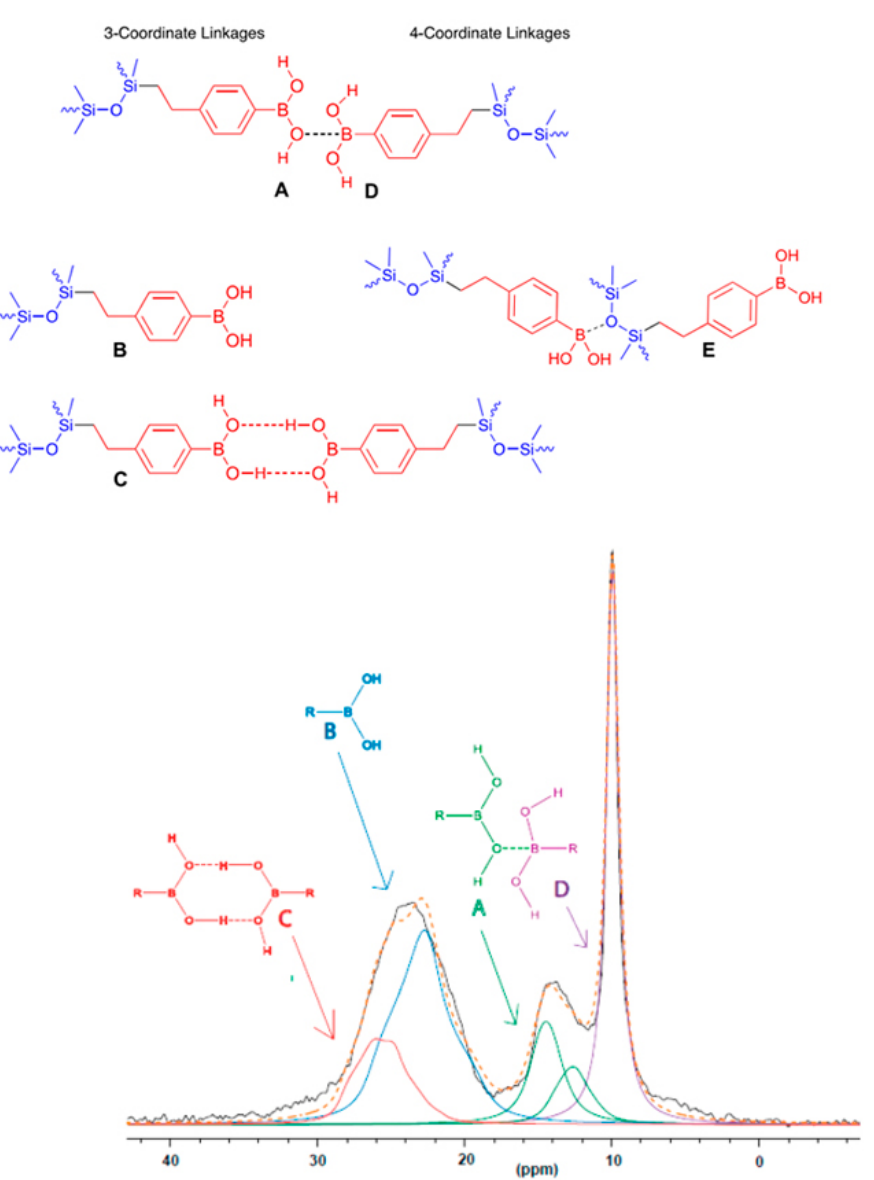
Figure 6. Types of noncovalent interactions between phenylborate moieties in organic PBSs and the type of MQMAS NMR spectrum that confirms their presence. Dative bonding between boronic acids (A), free boronic acid (B), and hydrogen-bonded boronic acids (C). Four-coordinate: dative bonding between a boronic acids (D) and dative bonding between a boronic acid and oxygen on the PDMS backbone (E). Reprinted with permission from [79]. Copyright 2019 American Chemical Society.